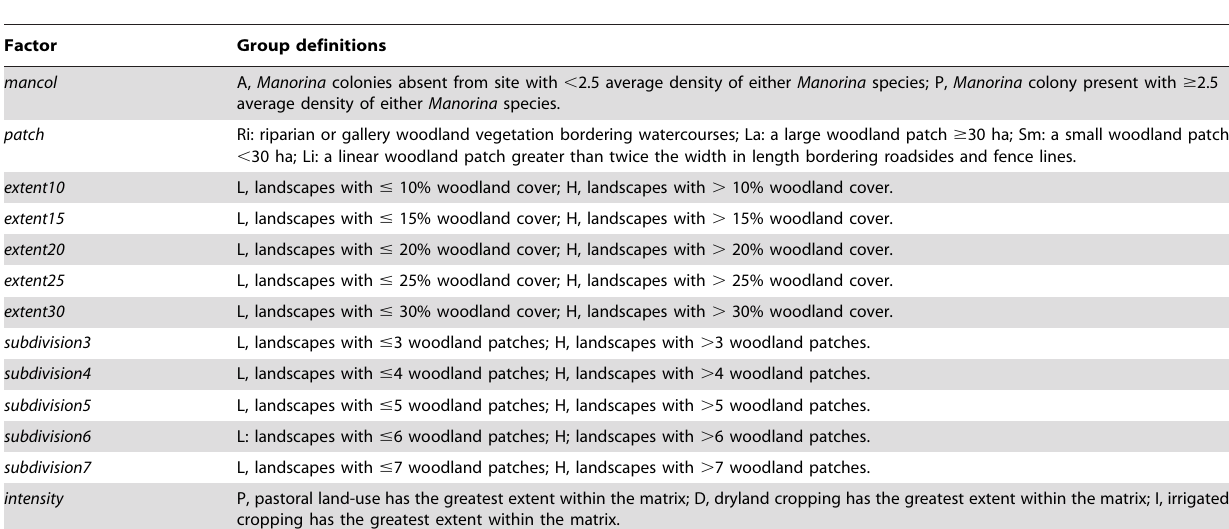
Table 2. Factors used in the PERMDISP test for homogeneity of dispersions for taxonomic and functional similarity between factor